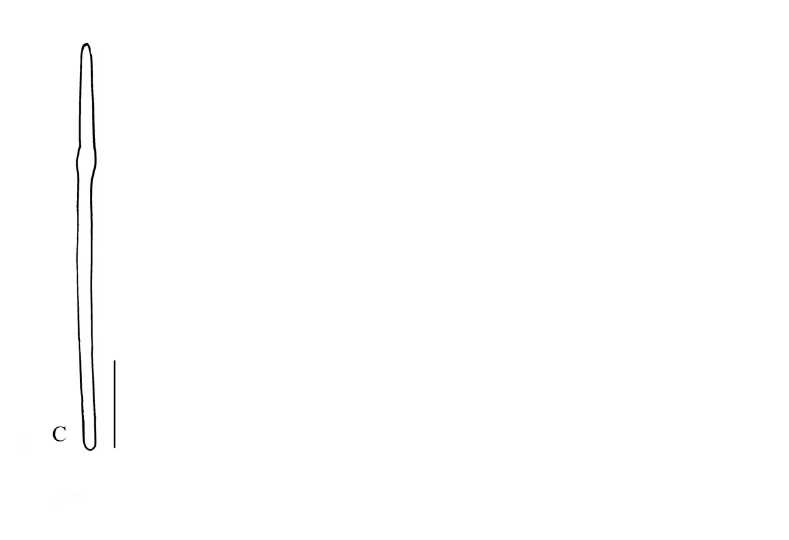
Figure 3. Chaetae of Ophidonais serpentina . ( A ) Anterior ventral, ( B ) posterior ventral, and ( C ) needles. ( D , E ) The end of needles. Scale bars: ( A – B ) 10 μ m, ( C ) 20 μ m, and ( D , E ) 5 μ m.